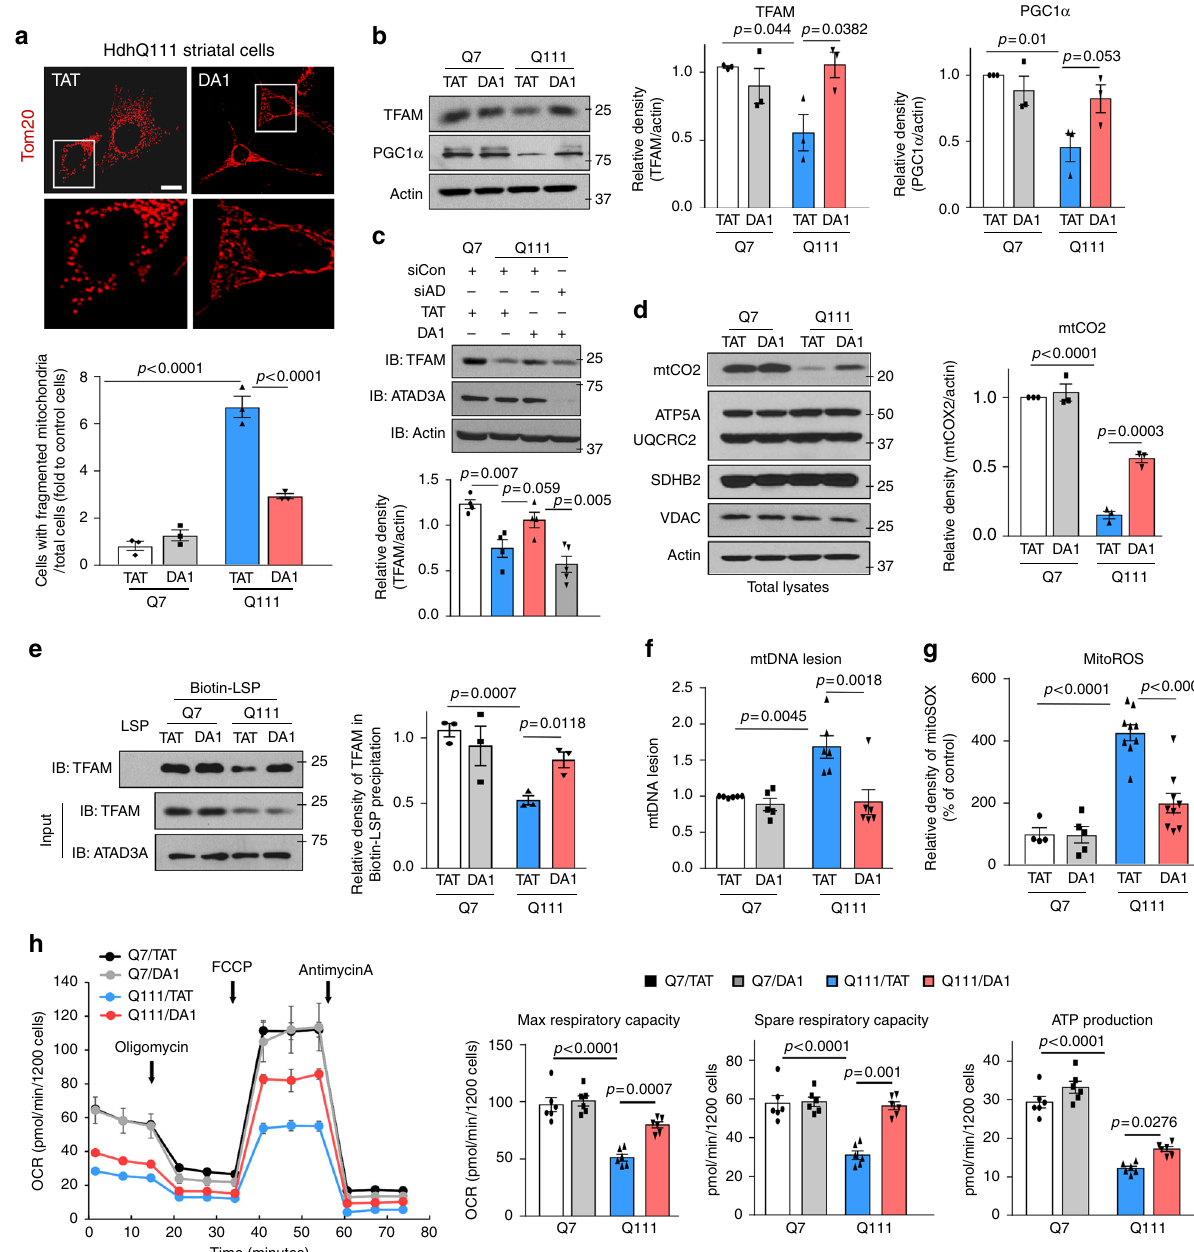
Fig. 6 DA1 treatment reduces mitochondrial damage and cell death in HD cell cultures. HdhQ7 and HdhQ111 striatal cells were treated with control TAT or peptide DA1 (1 µ M/day for 4 days). a Mitochondrial morphology was determined by staining cells with anti-Tom20 antibody. Scale bar: 10 µ m. The percentage of cells with fragmented mitochondria relative to the total number of cells was quantitated. Three independent studies, one-way ANOVA with Tukey ’ s post-hoc test. b TFAM and PGC1 α protein levels were analyzed by WB. Histogram: the relative density of TFAM and PGC1 α to Actin.